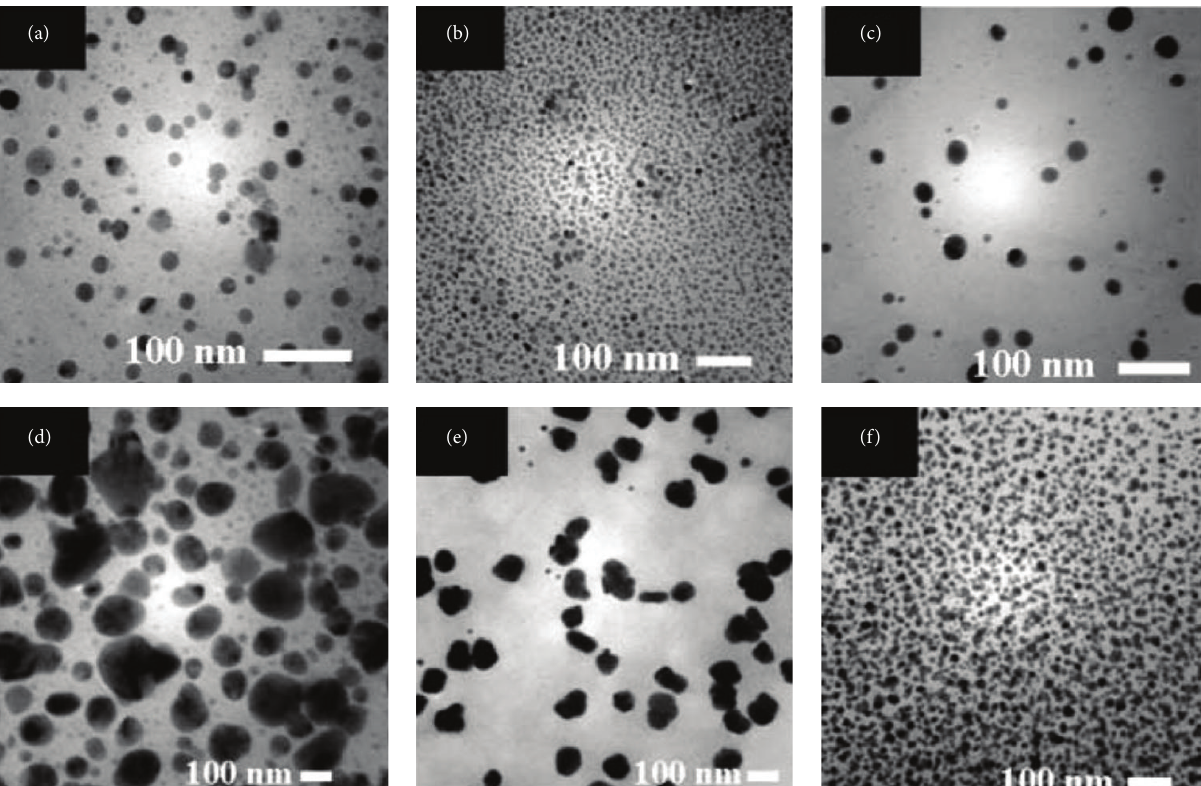
Figure 2: TEM image of silver nanoparticles synthesized using (a) Bigelow tea, (b) Folgers coffee, (c) Lipton tea, (d) Luzianne tea, (e) Sanka coffee, and (f) Starbucks coffee extract at room temperature in one step without using any hazardous reducing chemicals or nondegradable capping agents [42]. Copyright license number: